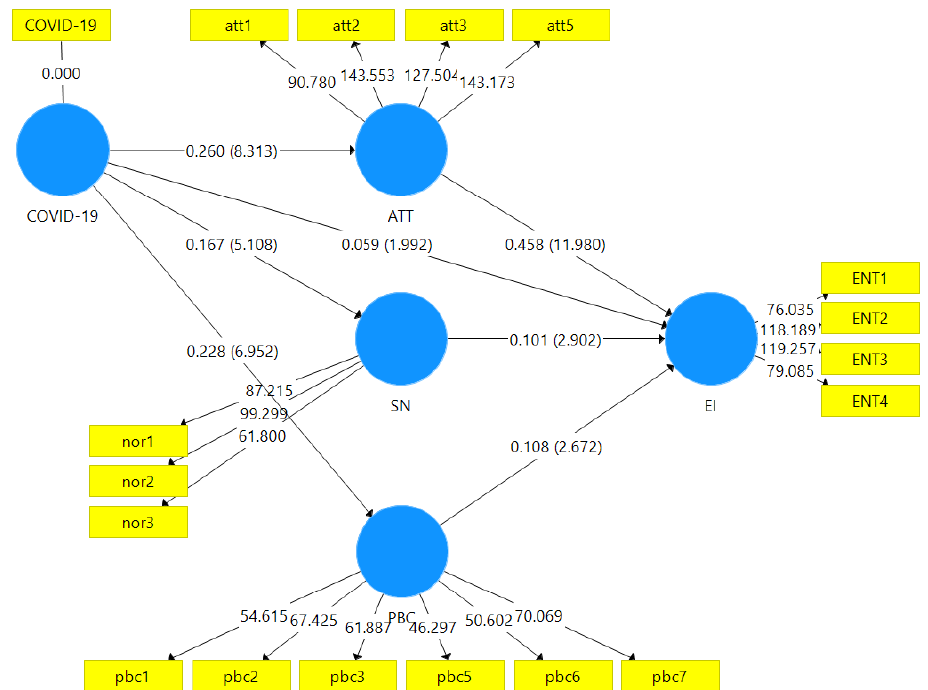
Figure 4. Path analysis — inner model: path coefficients ( t -values). Note : ATT, attitude; EI, entrepreneurial intention; PBC, perceived behavioral control; SN, subjective norms; COVID-19, the COVID-19 pandemic.